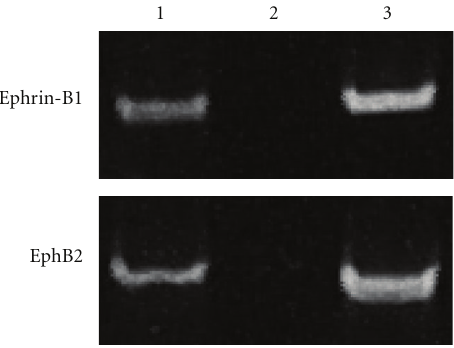
Figure 4: RT-PCR analysis for ephrin-B1 and EphB2 in human PBMC. Three kinds of templates were used to validate the results: lane 1, cDNA; lane 2, DNA-cleared RNA; lane 3; genomic